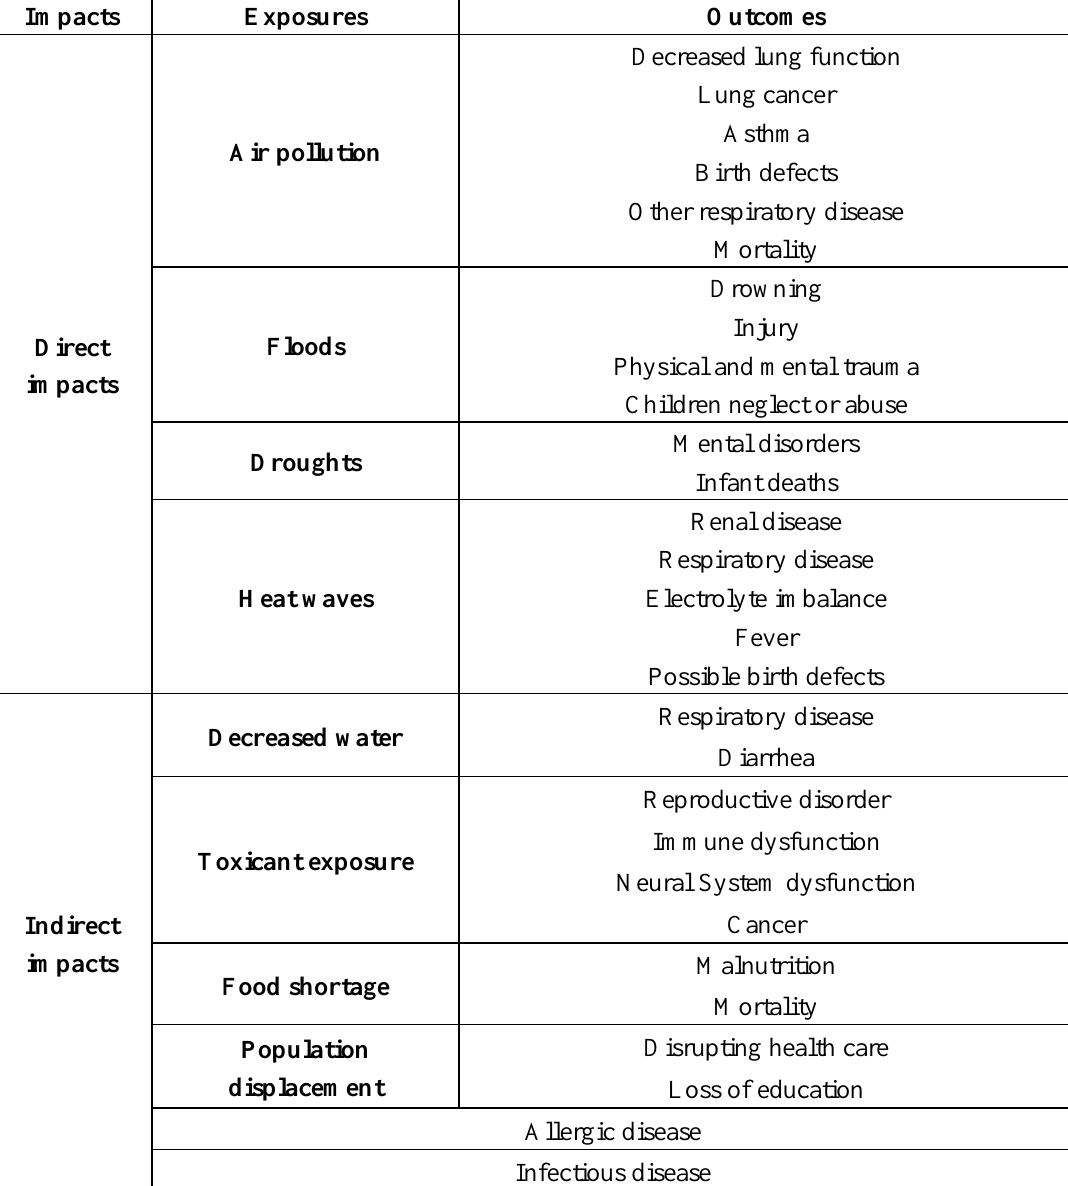
Table 1. Impact of climate change on children’s